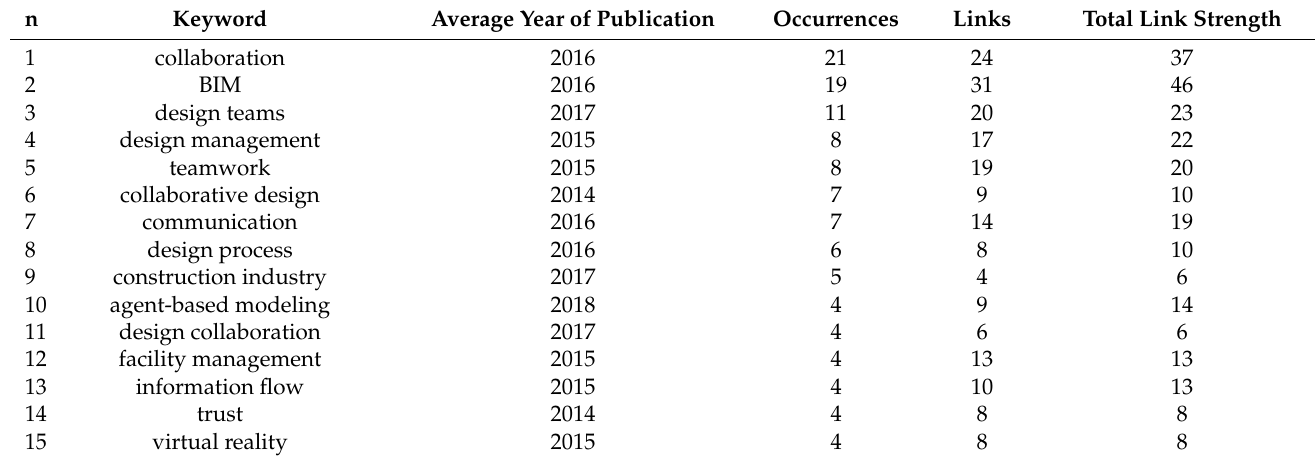
Table 3. Main keywords in selected articles, four or more